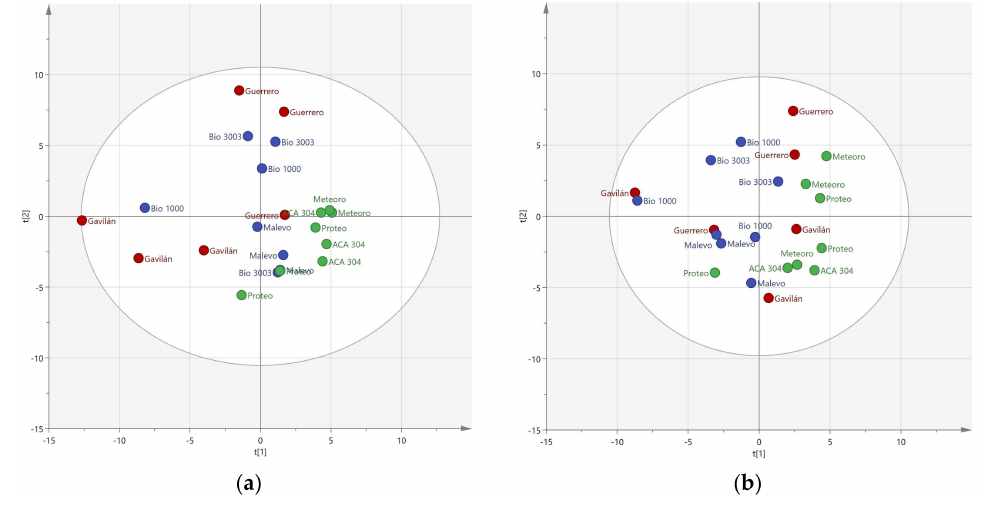
Figure 1. Principal components analysis: PC1 vs. PC2 of the cultivars under study (group 1—green; group 2—blue; group 3—red). ( a ) With, and ( b ) without added